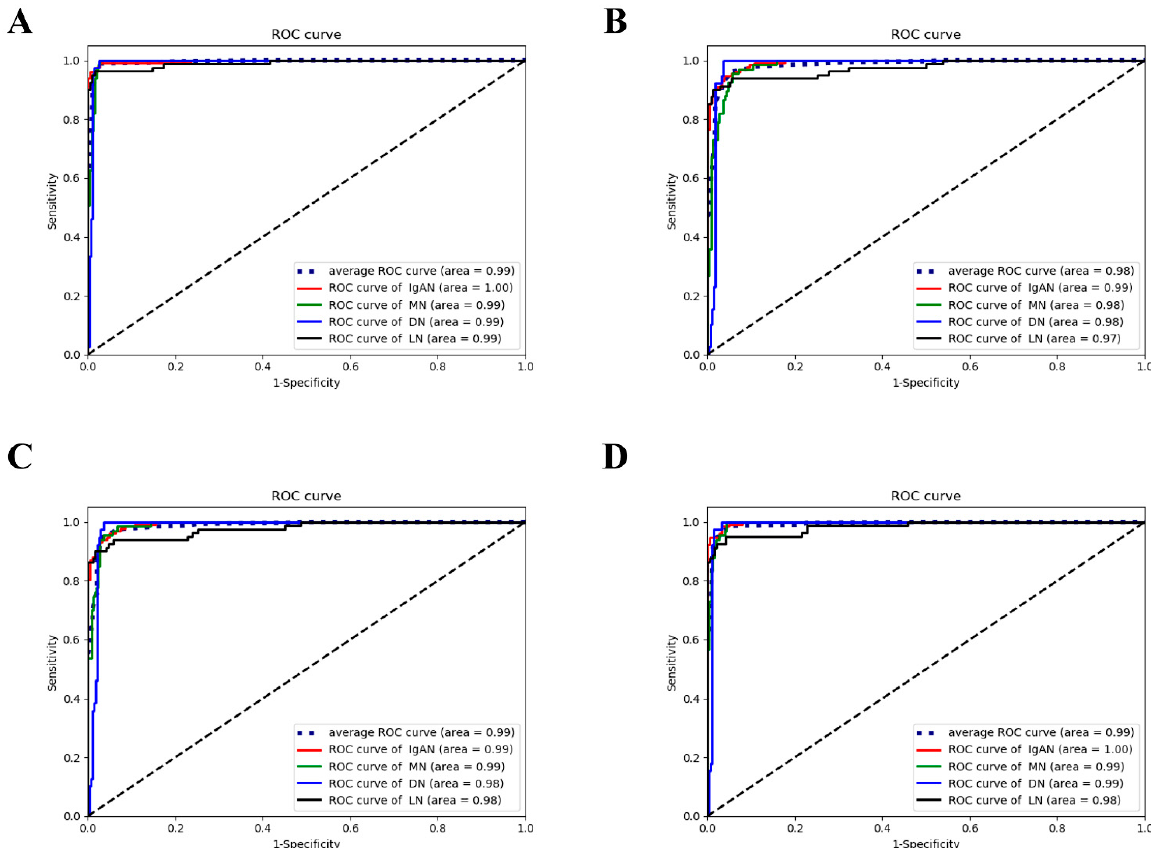
Figure 3. The ROC curve of each method. ( A ) ROC curve of non-blurred IF images test classification subnet; ( B ) ROC curve of blurred IF images test classification subnet; ( C ) ROC curve of blurred IF images test with the common MTL method; ( D ) ROC curve of blurred IF images test with the MTL-IF method. ROC: receiver operating characteristic; IgAN: IgA nephropathy; MN: membranous nephropathy; DN: diabetic nephropathy; LN: lupus